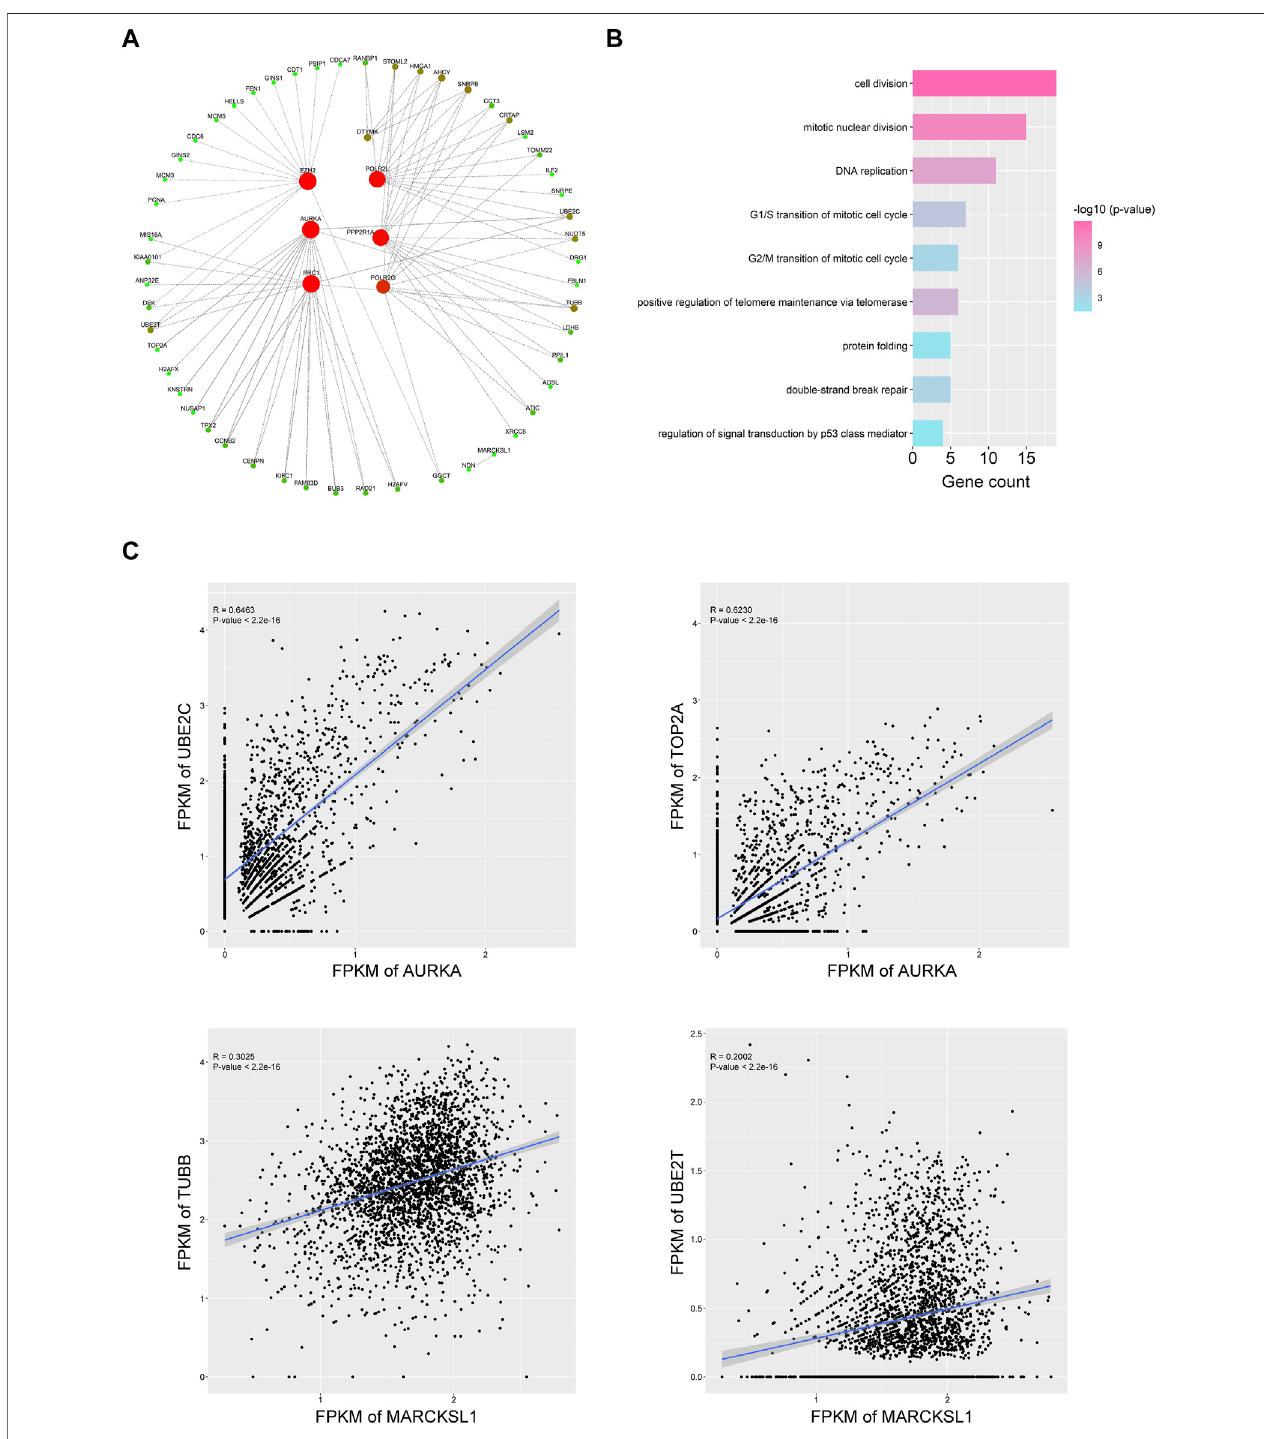
FIGURE 5 | Nine important PRGs participate in the cell cycle transition of HCC CSCs. (A) Coexpression network of the nine PRGs and their representative correlatedgenesinHCCCSCs. Interactionswithcoef fi cient > 0.3and p value < 0.001wereselectedforplotting. (B) RepresentativeGOtermsofcorrelatedgenesin (A) . (C) Typical examples of coexpression of PRGs and cell cycle-related genes in HCC CSCs.